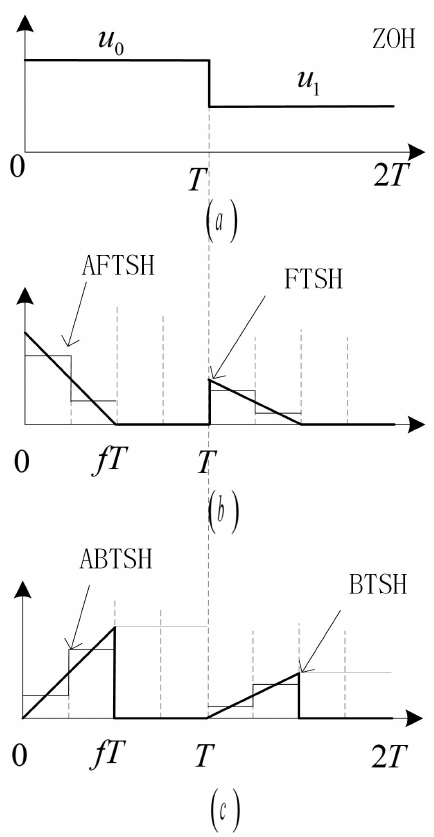
Figure 1. The structures of the signal reconstruction outputs of different sample and holds: ( a ) Zero- order hold. ( b ) FTSH and approximate FTSH (AFTSH) with N = 2. ( c ) BTSH and approximate BTSH (ABTSH) with N = 2